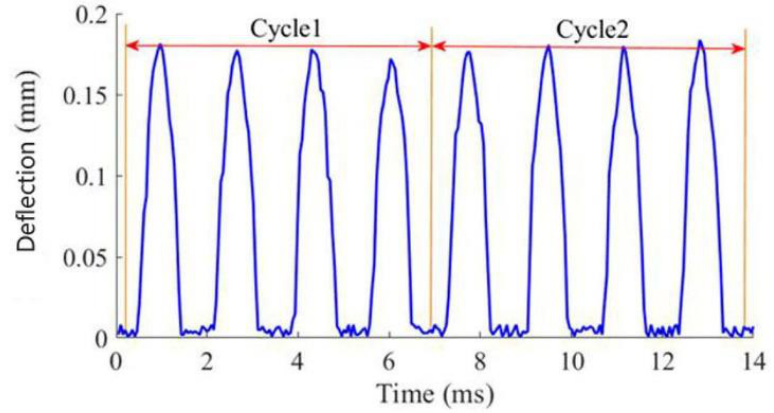
deflection. deflection.